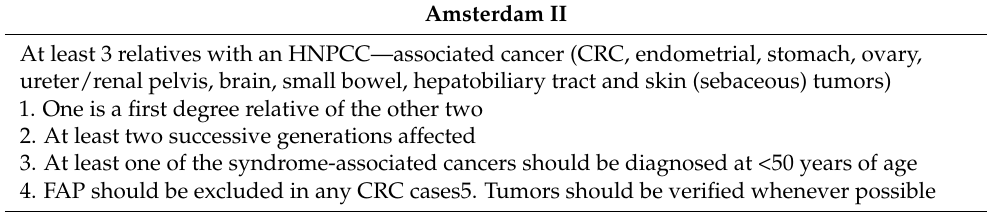
Table 1. Clinical Criteria for Lynch Syndrome Screening (adapted from